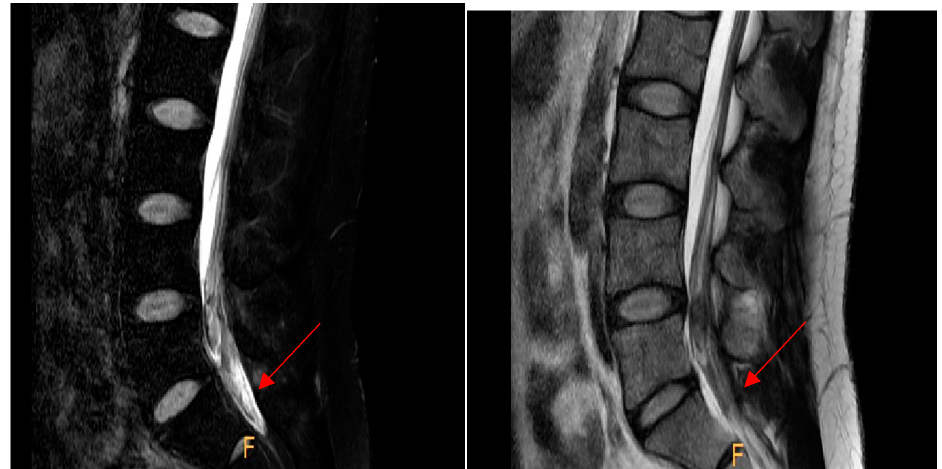
Figure 2. Hematoma (arrow) with a hyperintense signal at L4-5 and S1 on sagittal magnetic resonance imaging (MRI) (T1) on the left , and hematoma (arrow) with a hypointense signal on sagittal MRI (T2) on the right .